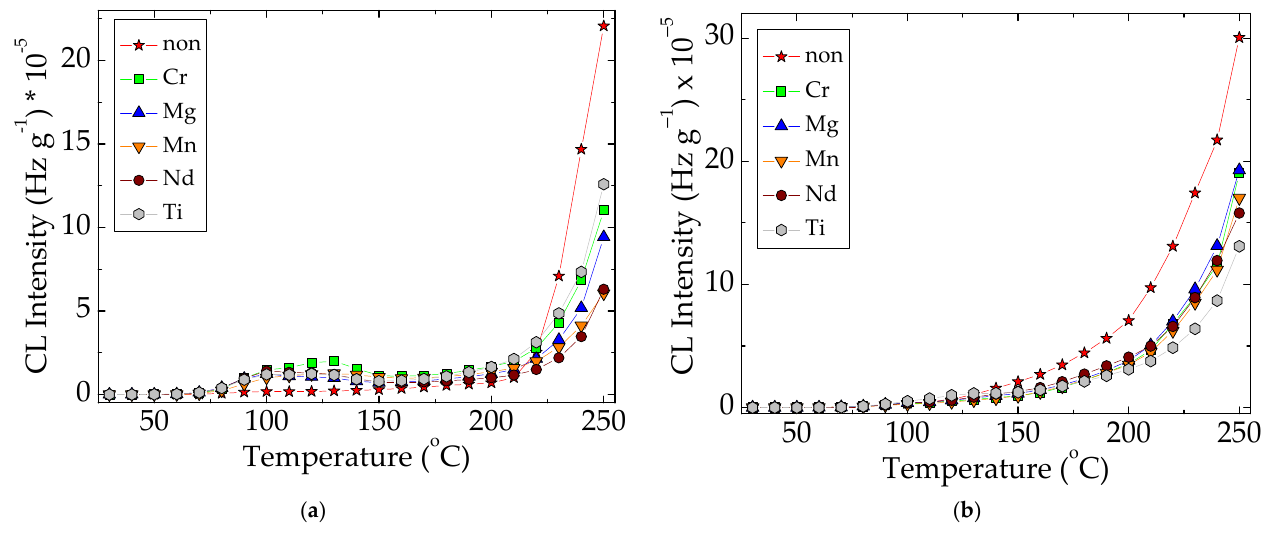
Figure 8. Nonisothermal CL spectra recorded on the PCL samples containing PbZrO 3 doped with various metallic atoms γ -irradiated at ( a ) 25 kGy and ( b ) 100 kGy. Heating rate: 10 °C min − 1 .